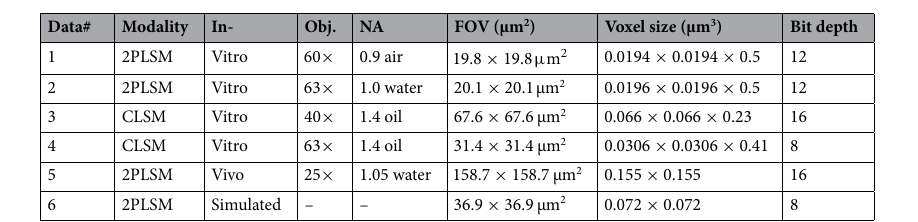
Figure 8. Dendritic spine gain/loss analysis using spine detection on simulated data. ( A ) An example simulated dendritic branch and with detected spines. ( B ) Actual and detected number of spines in four different examples of a simulated dendritic branch over 75 days with realistic spine turnover dynamics. ( C ) The similarity of temporal patterns between actual and detected spine numbers under different simulation noise conditions. Graphs show mean ± std. The similarity score is calculated using sMAPE-based similarity score quantification (mean ± std).